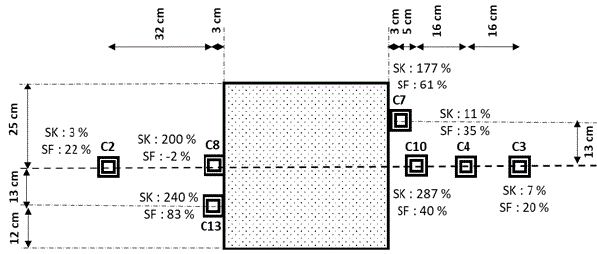
Figure 11. Comparison of load transfer in cases of granular soil (average of SF1 and SF2) and cohesive soils (SK1).